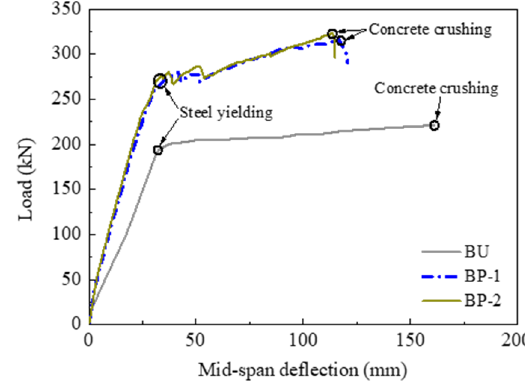
Figure 11. Influence of the prestressing system.